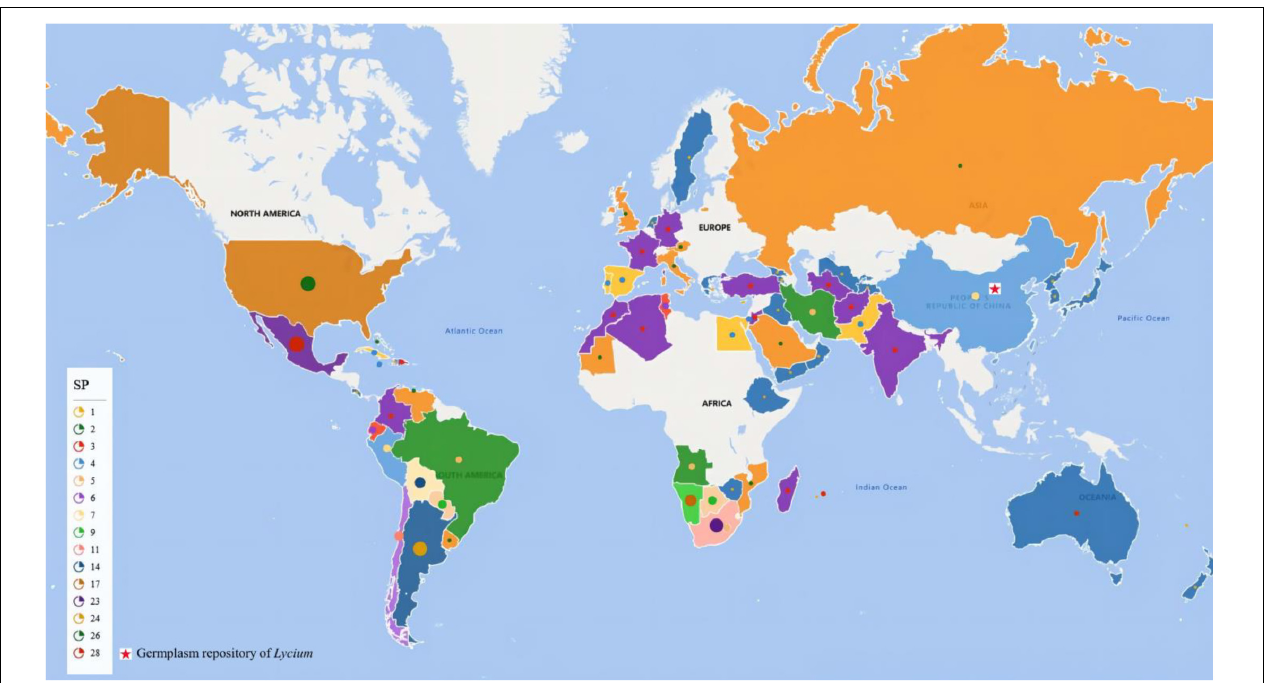
FIGURE 2 | Distribution of Lycium species worldwide. SP, species number. Dots with different colors and sizes indicate species numbers in the country marked by them. The red pentacle indicates the location of the germplasm repository of Lycium